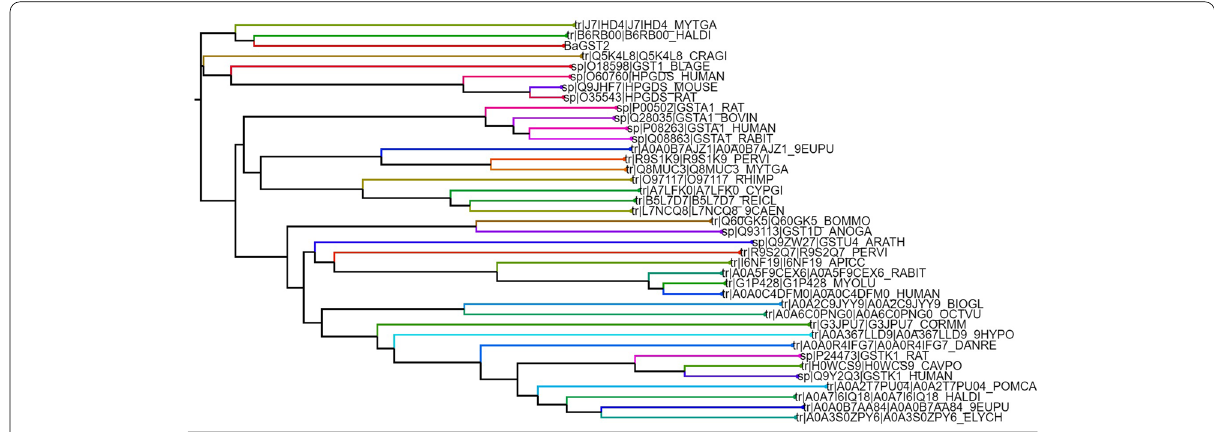
Fig. 7 Phylogenetic relationships between BaGST2 and GSTs from different classes. BaGST2 sequence with GSTs from 41 different GST classes (downloaded from the UniProt Knowledgebase) was aligned first using Clustal Omega (https:// www. ebi. ac. uk/ Tools/ msa/ clust alo/), and then, the phylogenetic tree was reconstructed. Sigma‑class GSTs are shown in yellow